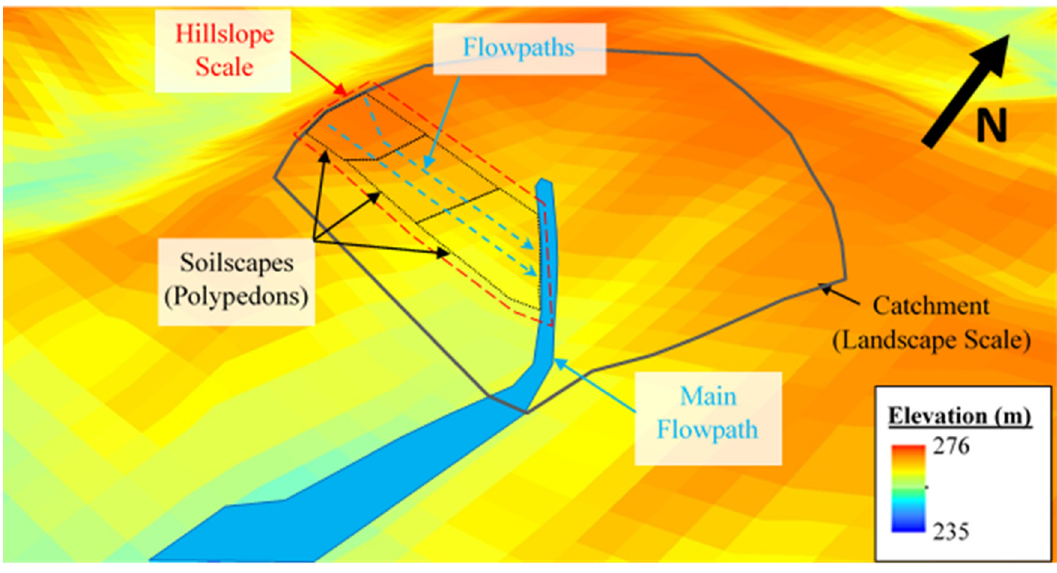
Figure 1. Conceptual sketch of flowpath connectivity within a hillslope.